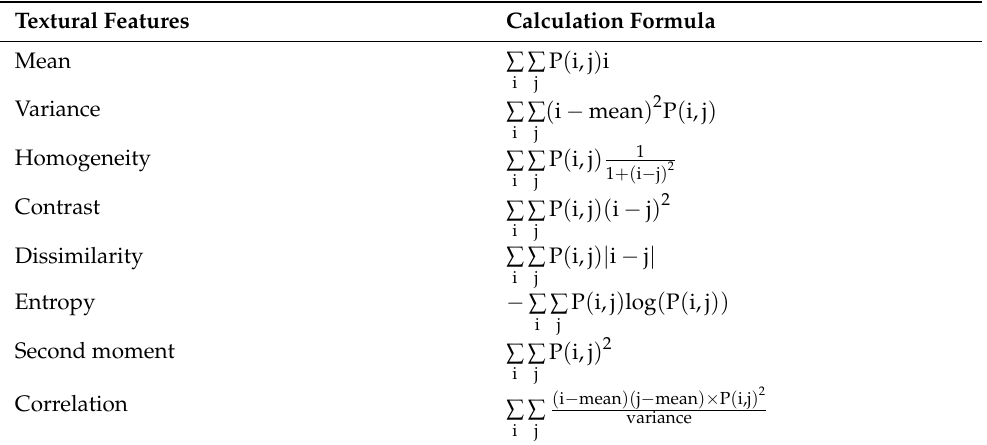
Table 2. Calculation formulas of textural